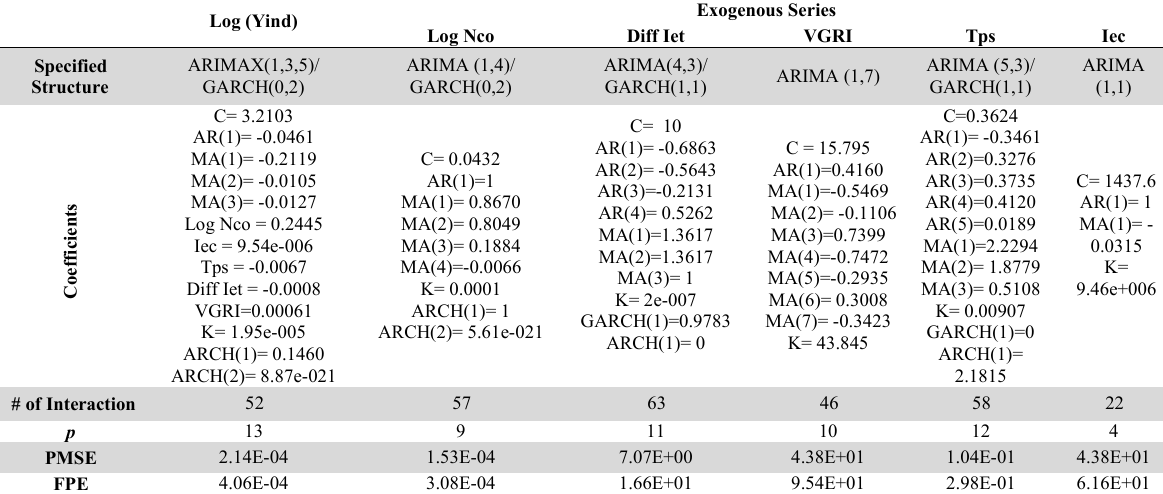
The results of model selection process of industrial peak